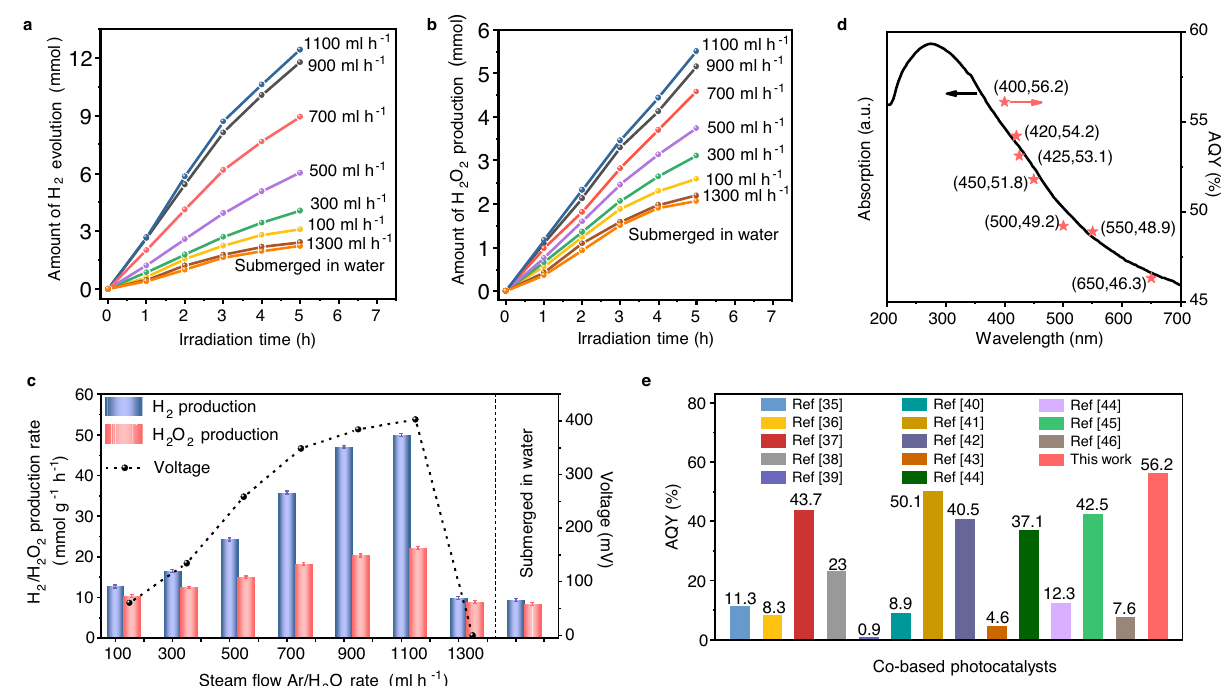
Fig. 3 | Photocatalytic water splitting performance of the hydrovoltaic effect- enhanced photocatalysis system. a Time-dependent photocatalytic H 2 produc- tion of PAA/CoO – NC at different Ar/H 2 O rates from 100 to 1300mlh − 1 , and sub- mergedinwater;Ptcocatalystisloadedusingaphotodepositionmethod;Thelight source is a solar simulator at AM 1.5G illumination (100mWcm − 2 ); b Time- dependent photocatalytic H 2 O 2 production of PAA/CoO – NC at different Ar/H 2 O rates from 100 to 1300mlh − 1 , and submerged in water; c The photocatalytic H 2 /